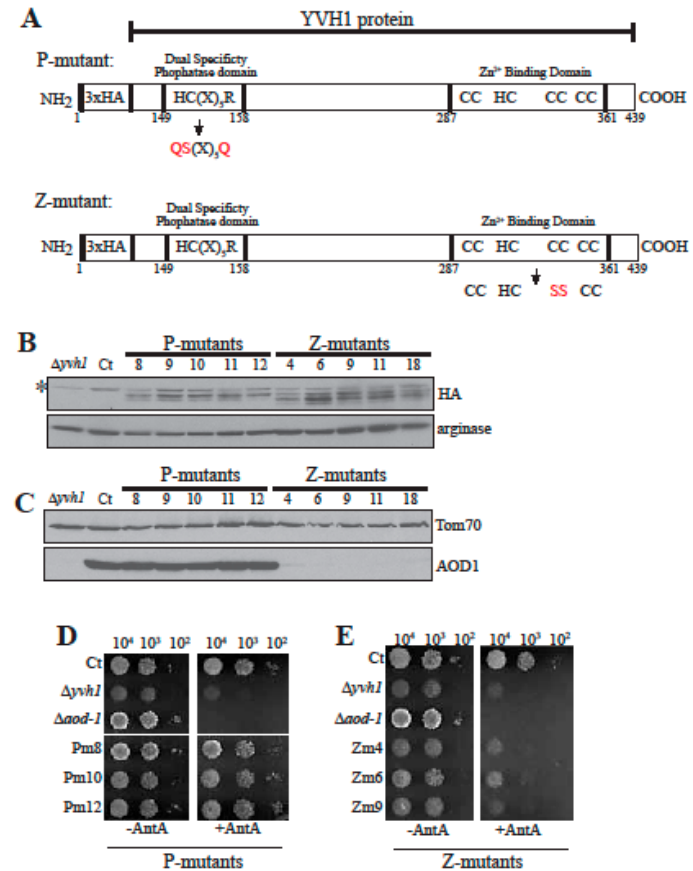
Figure 6. Analysis of phosphatase domain (P-mutants, Pm) and zinc binding domain (Z-mutants, Zm) mutants. ( A ) Representation of the N. crassa N-terminally 3xHA tagged YVH1 protein showing the position of amino acid changes introduced to create the P- and Z-mutants. The amino acid changes in the P-mutant are H149Q, C150S, and R156Q. The amino acid changes in the Z-mutants are C340S and C345S. The HA tag was not considered in the numbering of the amino acids. Changed amino acids are shown in red. ( B ) The 3xHA tagged mutant versions of YVH1 are expressed in isolated transformants of the ∆ yvh1 mutant. Whole cell extracts were prepared from the ∆ yvh1 strain, the NCN251 control (Ct), five isolates of P-mutant transformants, and five isolates of Z-mutant transformants. Cells were grown for 20 h in the presence of Cm. Proteins present in the cell extracts were separated by SDS-PAGE and blotted to nitrocellulose membranes. The blots were examined for HA and the loading control arginase. The * symbol indicates non-specific binding to an unknown protein by the HA antibody in the whole cell extract fractions. ( C ) Mitochondrial fractions were isolated from the same transformant strains expressing the Pm and Zm mutant versions of YVH1 that are shown in panel B. Strains were grown for 20 h in the presence of Cm. Proteins of the isolated mitochondria were separated by SDS-PAGE, blotted to nitrocellulose and probed with antibodies to AOD1, and Tom70 as the loading control. ( D , E ) Growth rate of selected N-terminal 3xHA tagged YVH1 P-mutants (Pm, D ) and Z-mutants (Zm, E ). Serial dilutions of conidia (indicated at the top of the panels) from the indicated strains were spotted on plates containing standard medium with ( + AntA) and without AntA ( − AntA). Plates without AntA were incubated at 30 ◦ C for 48 h. Plates containing AntA were incubated at 30 ◦ C for 68 h. Irrelevant rows were removed electronically. Ct, control strain NCN251. The ∆ yvh1 and ∆ aod-1 strains were also used as controls for growth rate.